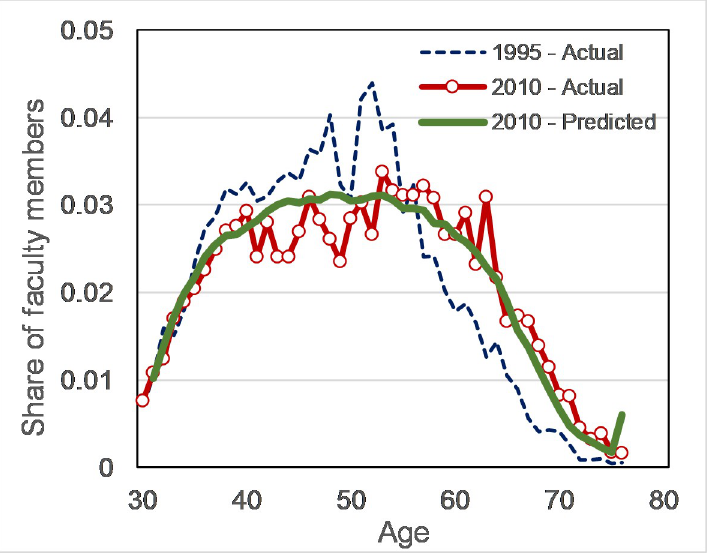
Fig 3. The age distribution of faculty members in 1995 and 2010 and the model’s prediction for 2010 (the correlation between predicted data and observed data in 2010 is 0.95).